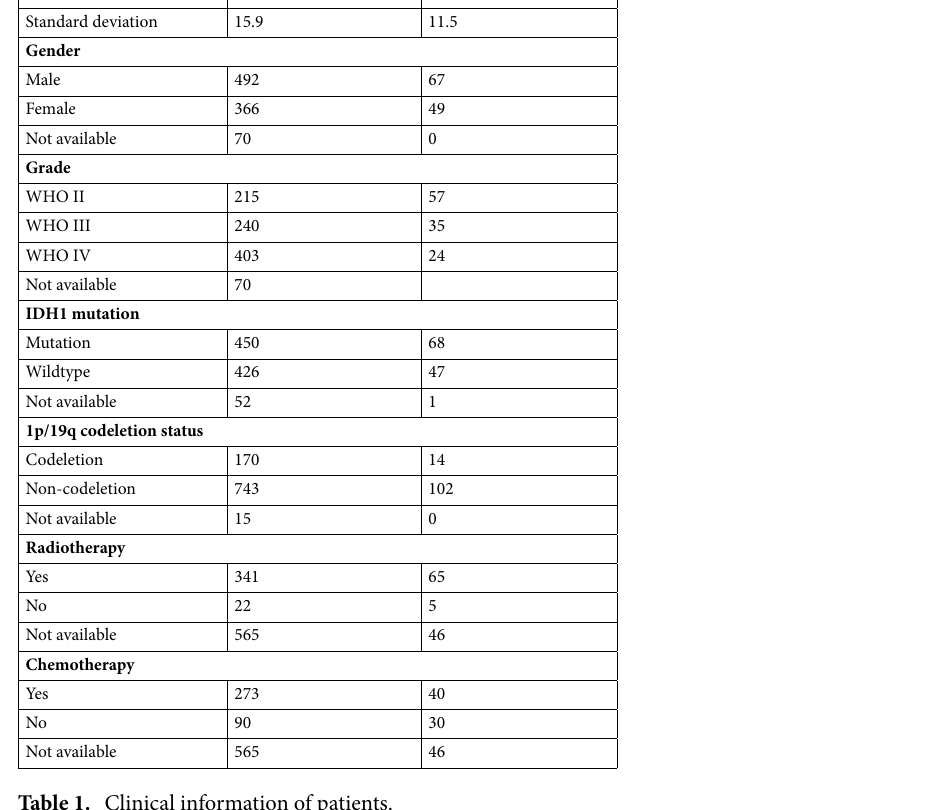
Table 1. Clinical information of